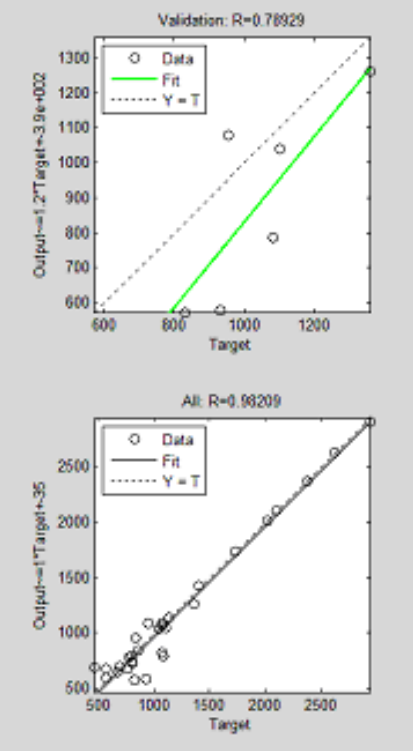
Fig. 4. Performance of ANN model during training of the